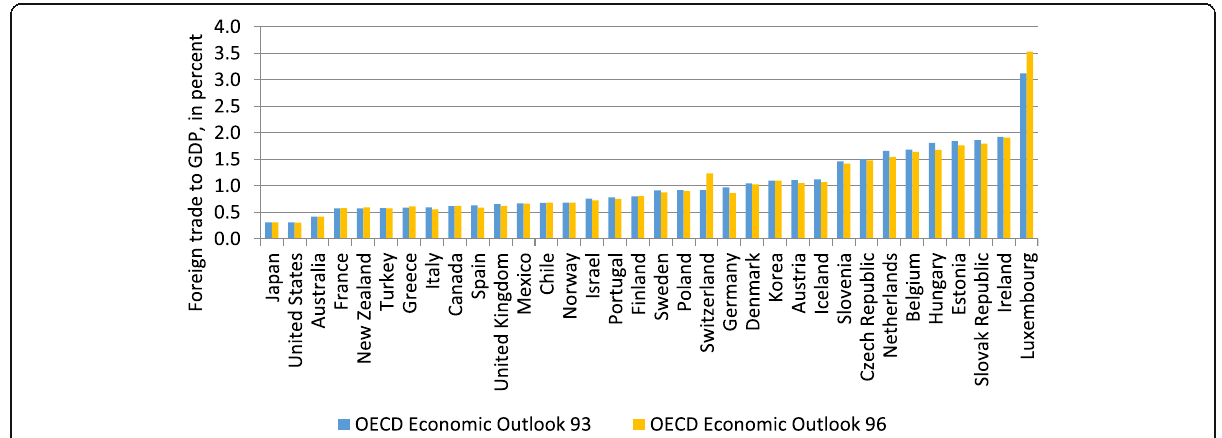
Fig. 12 Foreign trade to GDP. Year: 2012, Source: Authors ’ calculations, OECD (2013a), OECD